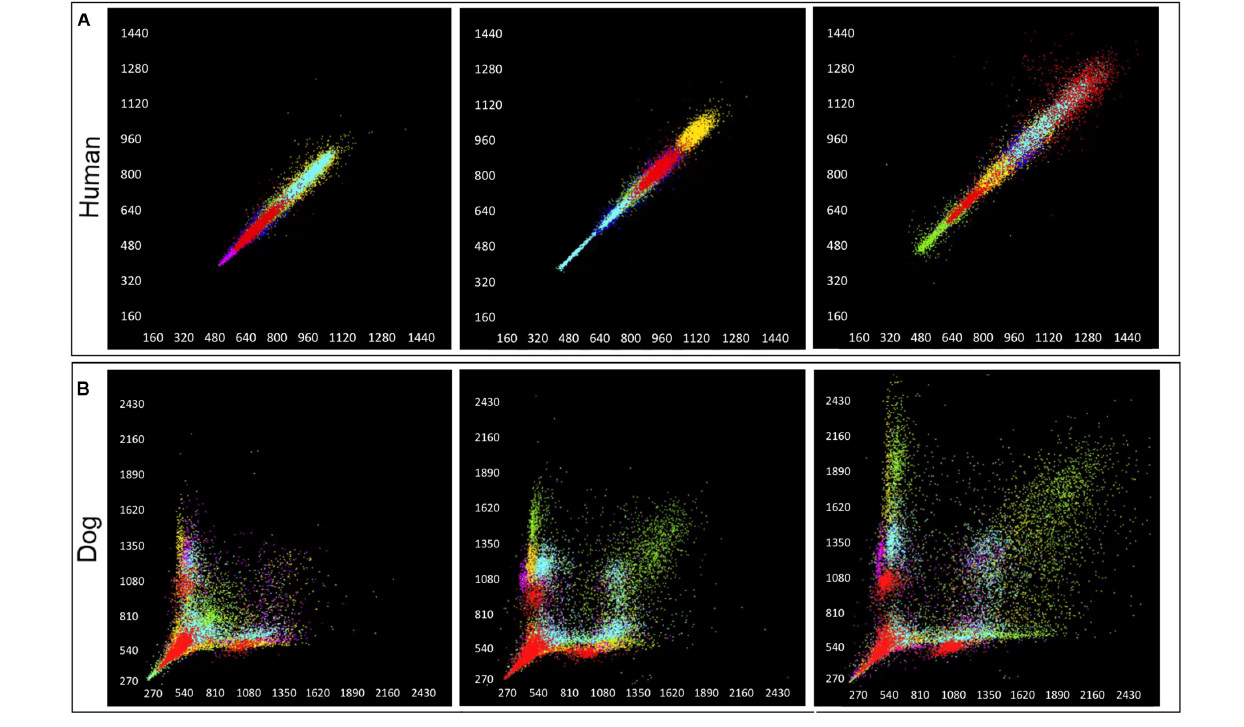
FIGURE 6 | ( Supplementary Videos 1, 2 ) Examination that is limited to still frames of two-dimensional geometric heart rate variability restricts understanding of the beat-to-beat dynamics. Here, frames captured from dynamic/animated two-dimensional Poincaré plots of five humans (A) and five dogs (B) provide the ability to examine heart rate dynamics in the human and dog.http://wyattflanders.com/poincare/ Each individual dog or human is represented by a different color. The R–R interval (X axis) and R–R + 1 interval (Y-axis) (intervals are in ‘ms’) are plotted with the ability to change the number of intervals represented (for clarity, labeling for these axes is omitted). The associated videos ( Supplementary Videos 1, 2 ) for these frames illustrate the difference between the dog and human concerning the beat-to-beat increasing and decreasing of heart rate and associated beat-to-beat changes. In the human, these changes occur primarily along the line of identity (diagonal line from lower left corner to upper right corner). In the dog as the beat-to-beat intervals increase they do so along the line of identity until approximately 600 ms when a bifurcation develops resulting in two ‘branches’ or ‘clusters’ along the X and Y axes. In the dog, a paucity of beats is noted for certain beat-to-beat intervals (zone of avoidance). The latter will not be evident if an excessive number of beats are shown. Additionally, some dogs develop a ‘cloud’ of long–long R–R intervals with an upper border along the line of identity. These videos can also have lines added and the speed adjusted so that the exact beat-to-beat interval relationships are seen (see Figure 8 and Supplementary Videos 3–6 ). Supplementary Videos 1, 2 correspond with this